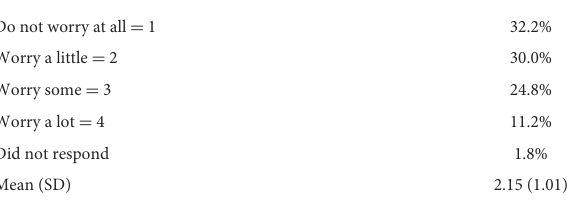
TABLE 5 Mean scores (SD) for perceived safety of different NBS practices under storm and non-storm